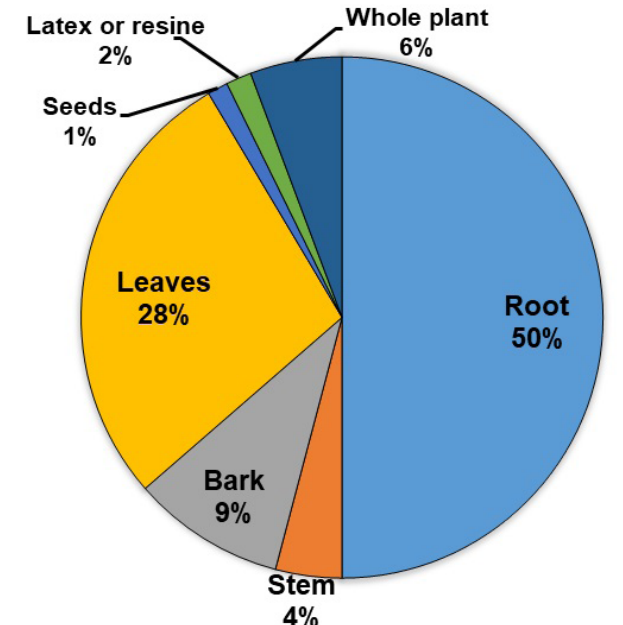
Figure 7. Ethnomedicinal plant parts used against snakebite in